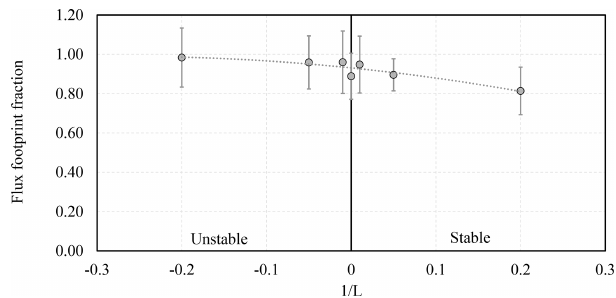
Figure 2. Estimated flux footprint fraction at Site 2 plotted versus atmospheric stability (the reciprocal of the Obukhov length L ). The model results are for a roughness length z 0 = 0 .